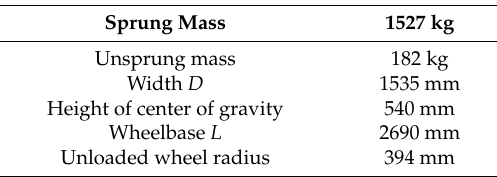
Figure 5. Philsophy of K gain adjusting.